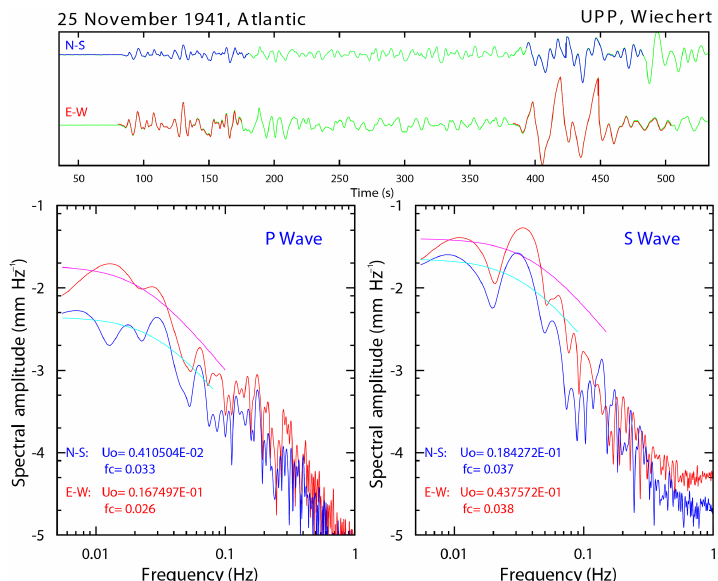
Figure 2. Top panel: digitized seismograms corresponding to the N–S and E–W components of the 1941 Atlantic earthquake as recorded by the Wiechert seismograph at Uppsala (UPP). Bottom left panel: ground motion spectra of the P waves, as marked at the top figure (blue and red, respectively), recorded at UPP, and the corresponding fit to the Brune model. Bottom right panel: ground motion spectra of the S waves, as marked at the top figure (blue and red, respectively), recorded at UPP, and the corresponding fit to the Brune model.